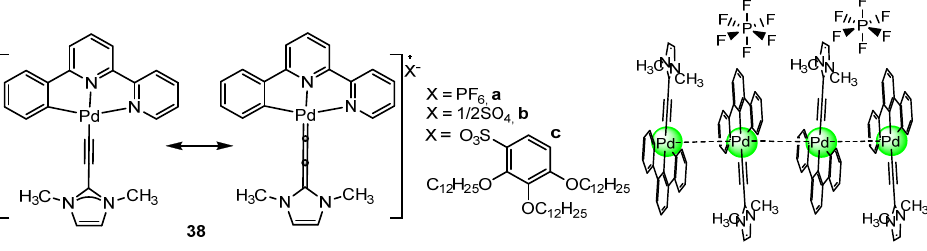
Figure 11. Schematic representation of the palladium(II) N-heterocyclic allenylidene complexes 38